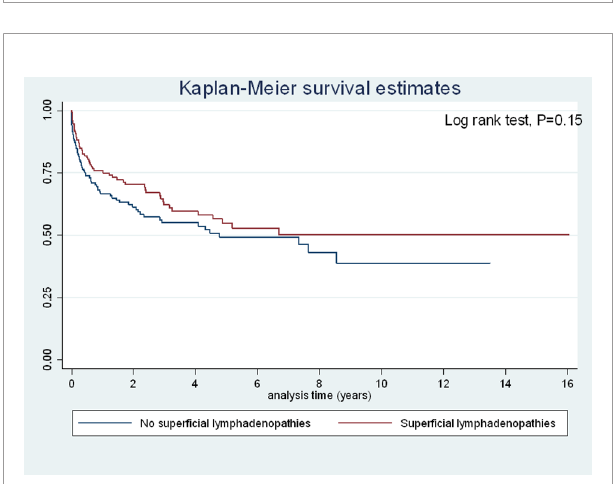
FIGURE 3 | Incidence of death among patients with disseminated histoplasmosis strati fi ed by the presence of deep lymphadenopathies.